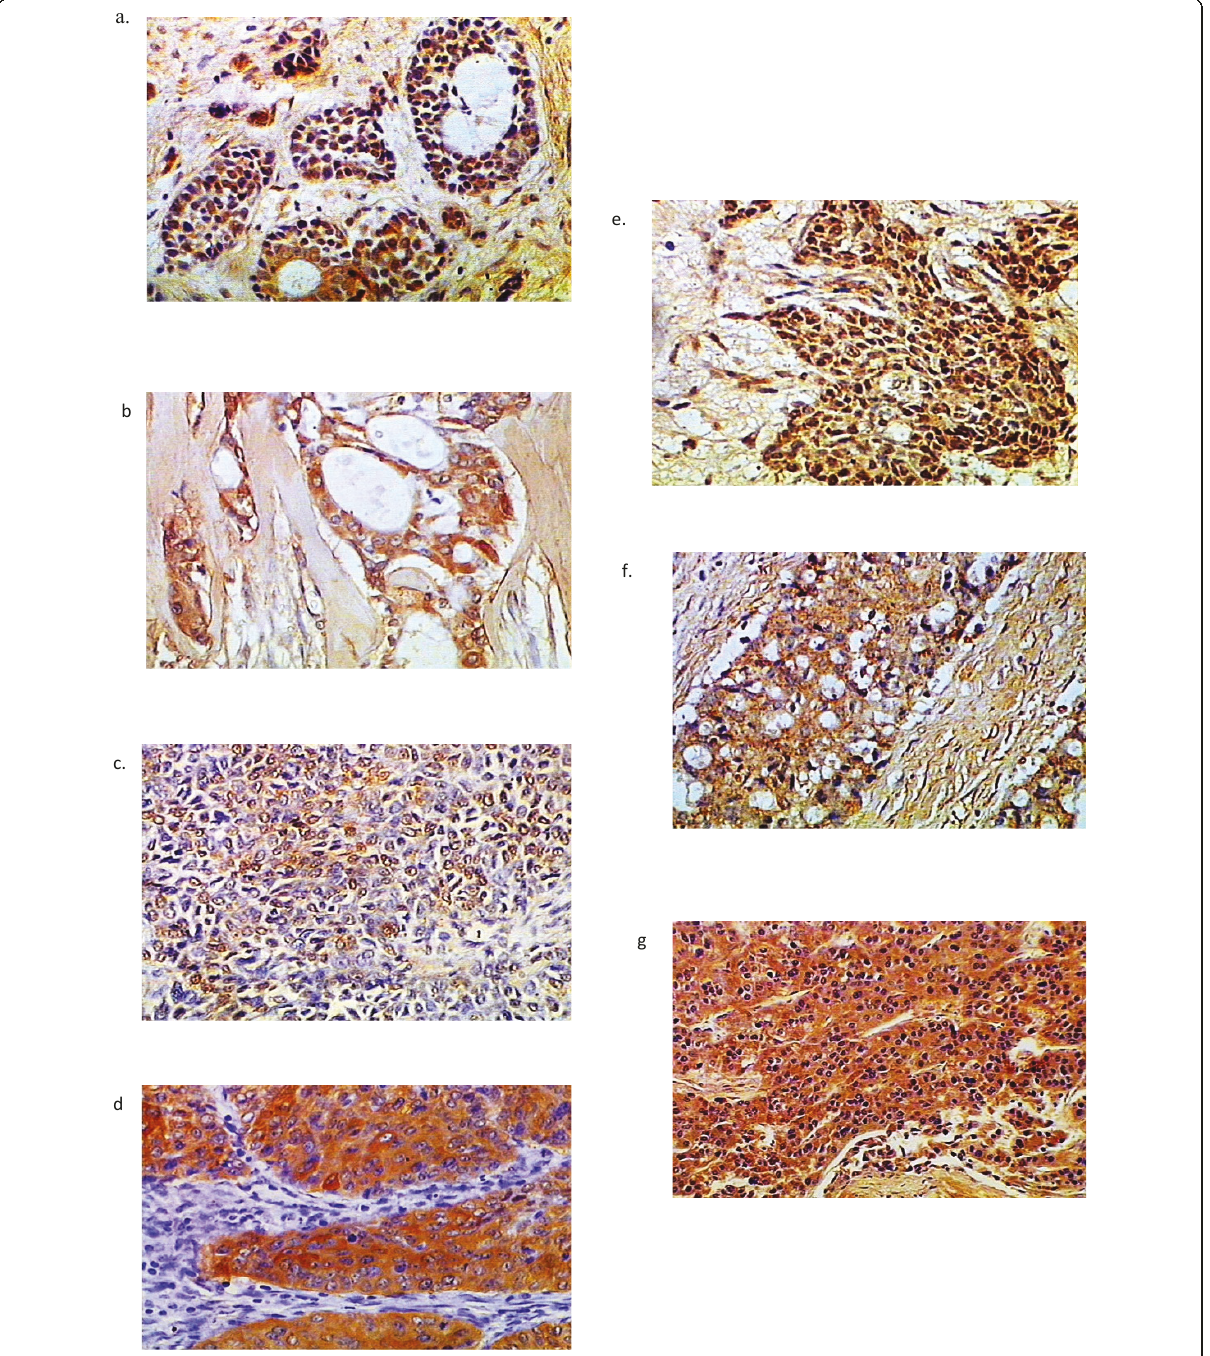
Figure 1 Maspin expression patterns in salivary gland carcinomas . a: low grade MECx200. b: ADCCx200. c: EMCx200. d: SDCx200. e: MPAx200. f: PLGAx200. g: